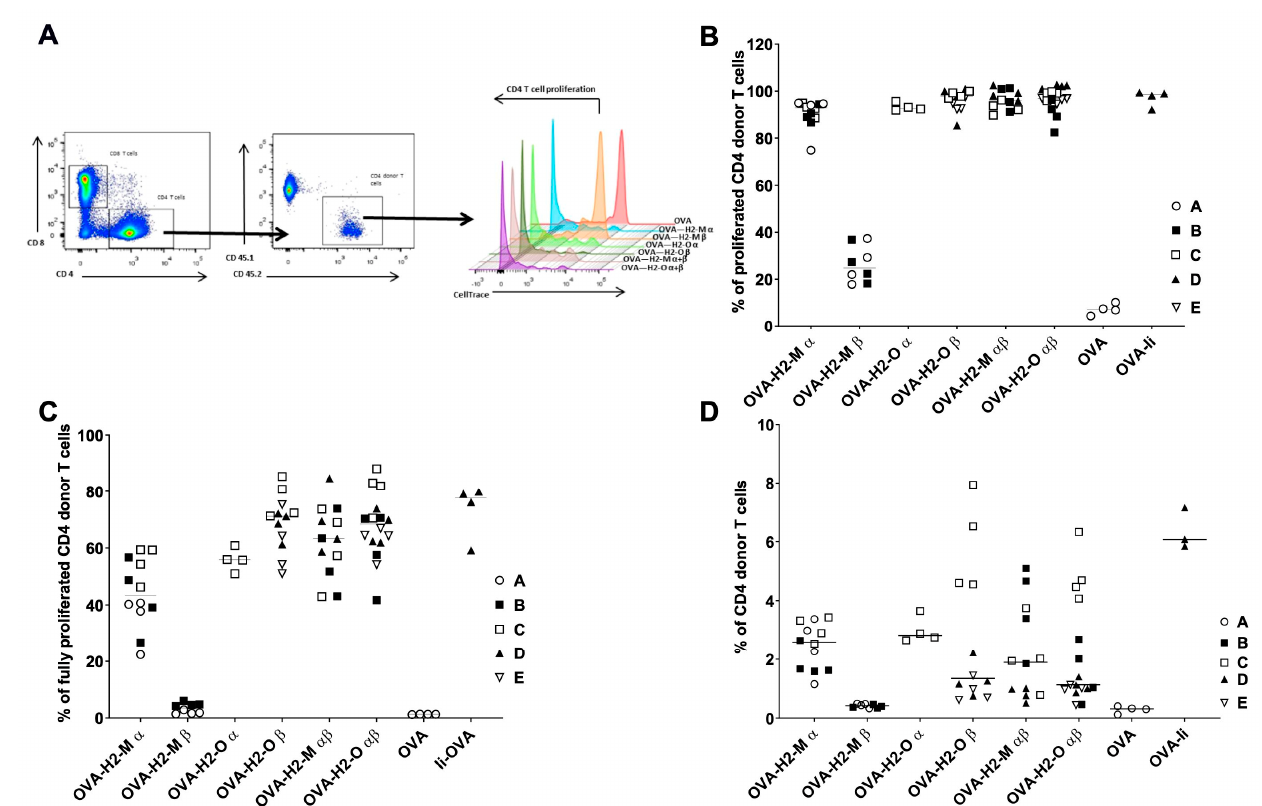
Figure 3. Enhanced CD4+ T cell proliferation in vivo mediated by the insertion of H2-M and H2-O fusion-protein sequences. ( A ) Quantification of in vivo CD4+ T cell proliferation generated by coupling OVA to selected trafficking signal sequences. Flow cytometry plots and histograms showing the analysis and quantification of the decline in vital cell tracer dye staining in proliferating CD4+ T cells. CD45.1 mice were adoptively transferred i.v. with CellTrace-labeled CD45.2/CD4/OTII cells and 24 h later immunized i.v. with formulated OVA-fusion mRNAs formulated with Lipofectamine MessengerMax. T-cell proliferation was measured at 5 days post CD4+ T cell transfer by flow cytometry after staining with the indicated fluorescent antibodies. CD4+ T cell proliferation was determined by measuring the percentage of all proliferating cells and the percentage of cells in the last division peak, respectively, as shown in the graphs. ( B ) In vivo quantification of CD4+ T-cell proliferation in all stages generated by coupling OVA to H2-M and H2-O sequences. Enhanced CD4+ T-cell proliferation mediated by H2-M and H2-O sequences. Data are shown as frequency of proliferating donor CD4+ T cells 3 days after the injection of 5 µg of mRNA. T-cell proliferation was determined by measuring the percentage of all proliferating cells. An mRNA-encoding part of the sequence of Invariant chain (Ii) was used as a positive benchmark. Data shown are a combination of five independent experiments (A–E), four female mice per group. ( C ) In vivo quantification of CD4+ T-cell proliferation in the latest stage generated by coupling OVA to H2-M and H2-O sequences. Data represent the percentage of proliferating CD4+ donor T cells in the highest proliferation stage, determined by measuring the percentage of proliferating cells in the last division peak. ( D ) Quantification of donor CD4+ T cell expansion generated by coupling OVA to H2-M and H2-O sequences. Data represent the percentage of donor CD4+ T cells relative to the recipient CD4+ T cells. Five independent experiments are represented (A to E), four mice per group. Invariant chain fusion protein (Ii) was used as a positive